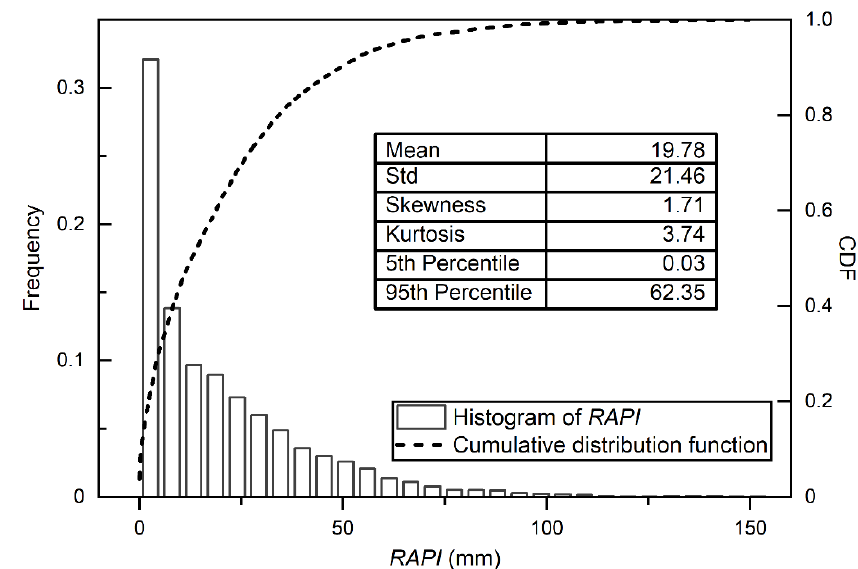
Figure 4. Statistical characteristics of the optimal RAPI .